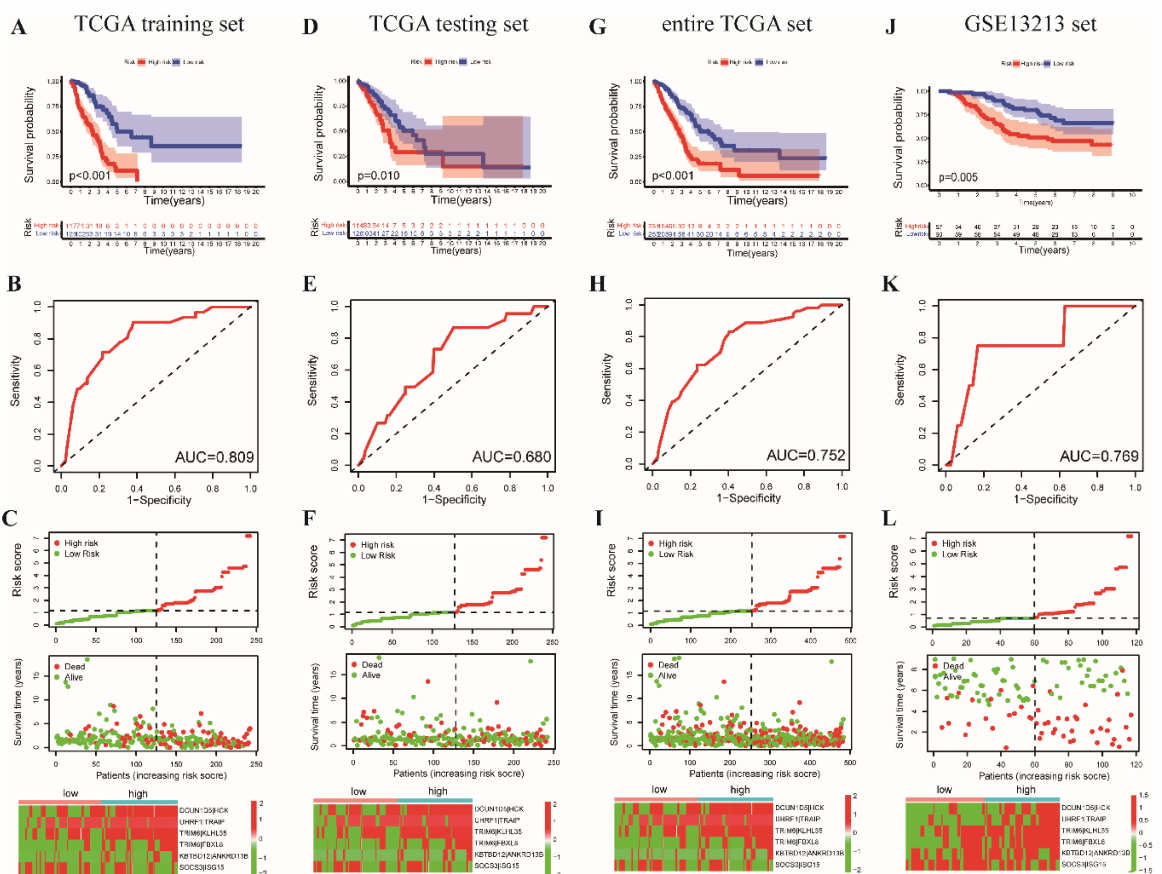
Figure 5. The survival curves of patients with LAUD in the low- and high-risk groups in the ( A ) training, ( D ) testing, ( G ) TCGA, and ( J ) GSE13213 sets. The AUC was predicted for 1-year survival prediction in the ( B ) training, ( E ) testing, ( H ) TCGA, and ( K ) GSE13213 sets. The risk score, survival status distribution, and heatmap of the expression of the 6 UbRGPs in patients in the ( C ) training, ( F ) testing, ( I ) TCGA, and ( L ) GSE13213